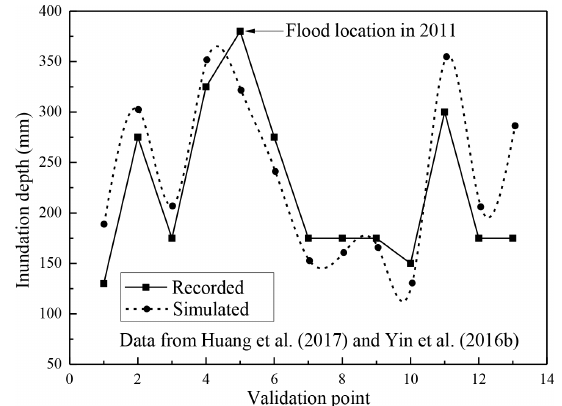
Figure 9. Comparison of the inundation depths obtained from the simulated results and recorded